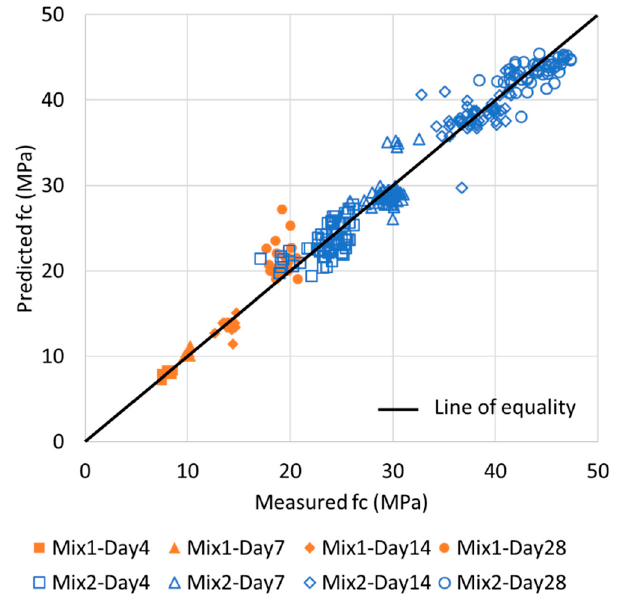
Figure 17. Relationship between measured fc (experimental values) and predicted fc (theoretical values) by the ensemble method.